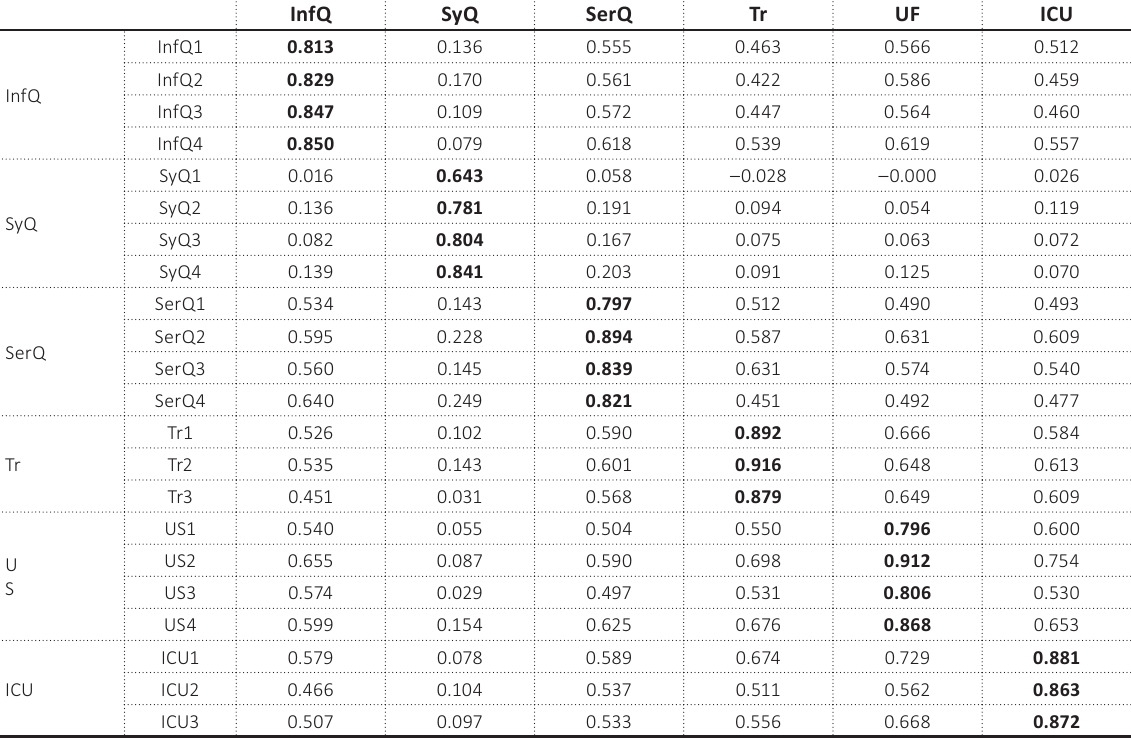
Table 2. Factor loadings and cross-loadings